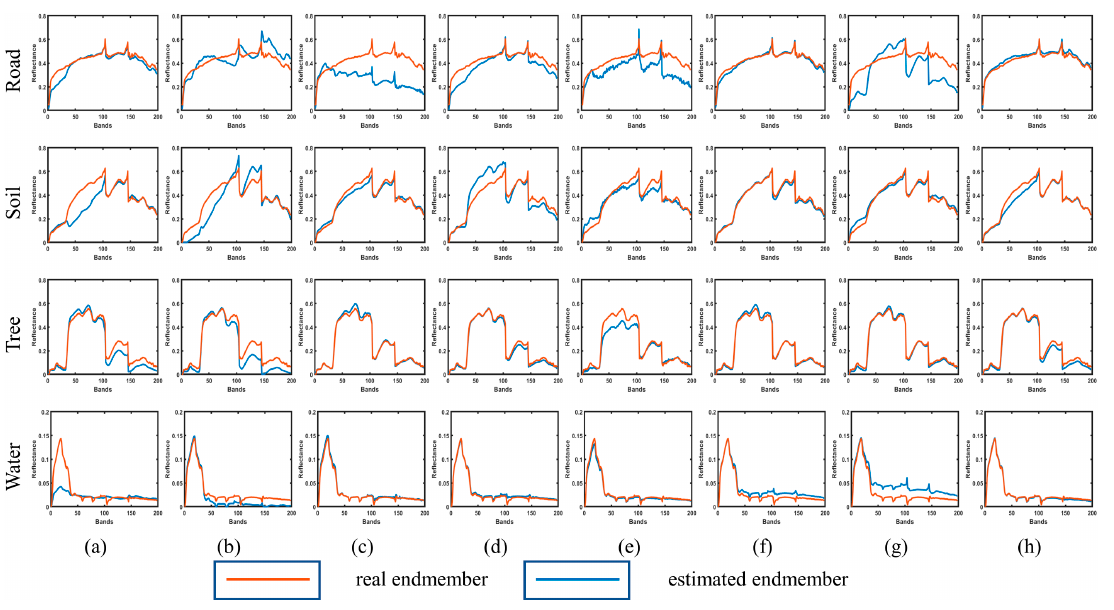
Figure 14. Visualization results of the endmembers of Jasper Ridge data. ( a ) VCA-FCLS. ( b ) SGCNMF. ( c ) DAEU. ( d ) MTAEU. ( e ) CNNAEU. ( f ) CyCU-Net. ( g ) MiSiCNet. ( h ) SSANet.